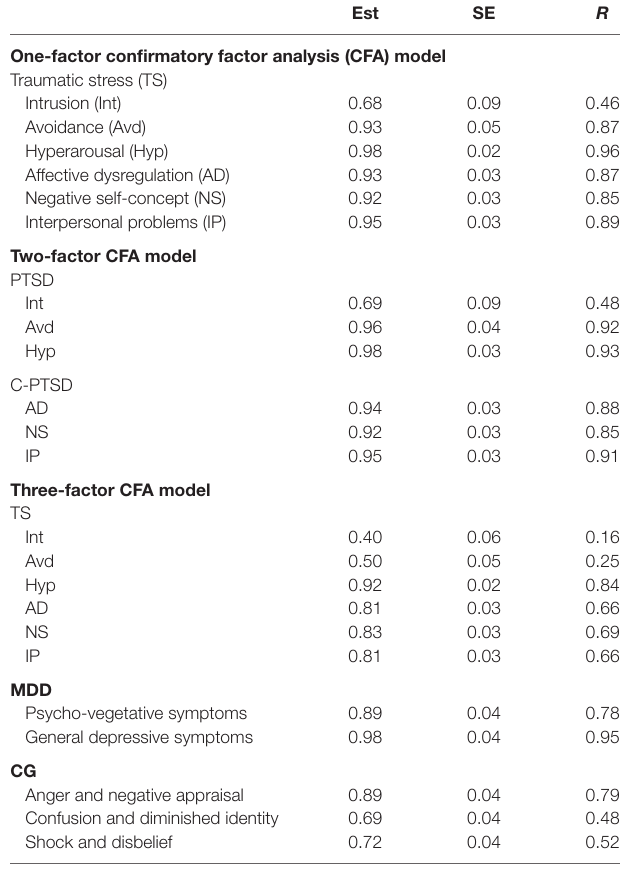
TaBle 3 | standardized factor loadings for first-order confirmatory analysis of symptoms of PTsD and c-PTsD.